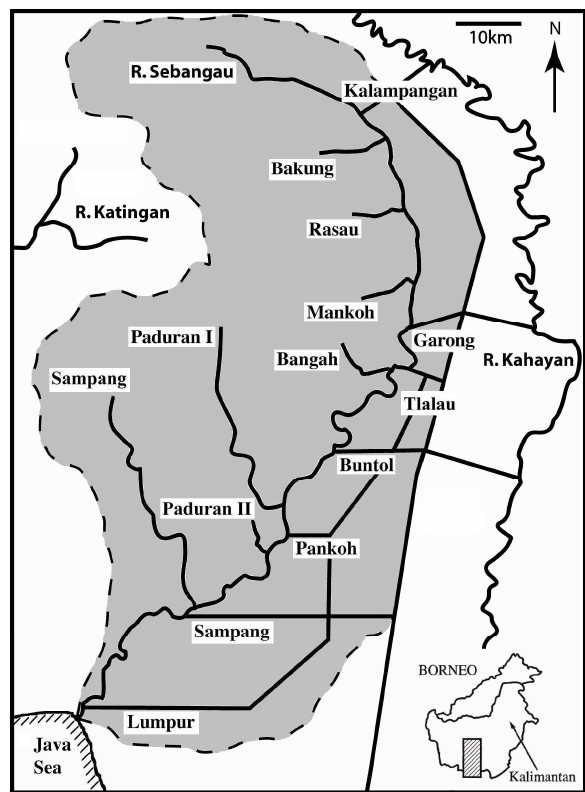
Fig. 2. Fig. 2. Map of the Sebangau River basin in Central Kalimantan, Borneo (inset). The Sebangau watershed is shaded grey and out- lined by the dashed line to the west and the straight solid line (north- south canal) to the east. Fourteen named channels drain the Seban- gau catchment into the River Sebangau (centre) which runs from North to South draining into the Java Sea. To the west of the north- ern stretches of the Sebangau River lies the Sebangau National Park which contains intact PSF (Page et al., 1999). To the west of the southern stretches of the Sebangau is a transmigration settlement area which experienced deforestation and land-use change in the 1970s through to the 1990s. The east side of the Sebangau basin is “Block C” of the Ex-Mega Rice Project (EMRP). The EMRP, which began in 1995, converted peatland into land suitable for agriculture by clearing the land and creating drainage canals to artificially con- trol water table levels (Hooijer et al., 2008). A combination of peat- land drainage and fires has created a much changed and degraded ecosystem (Page et al., 2002; W¨osten and Ritzema, 2007; Ballhorn et al., 2009; Page et al., 2009).